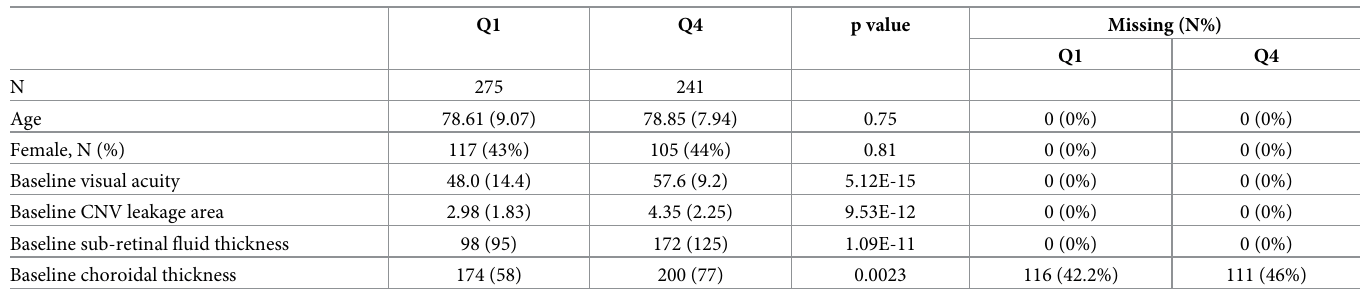
Table 1. Quartile Q1 and quartile Q4 AMD HARBOR patient demographic comparison.